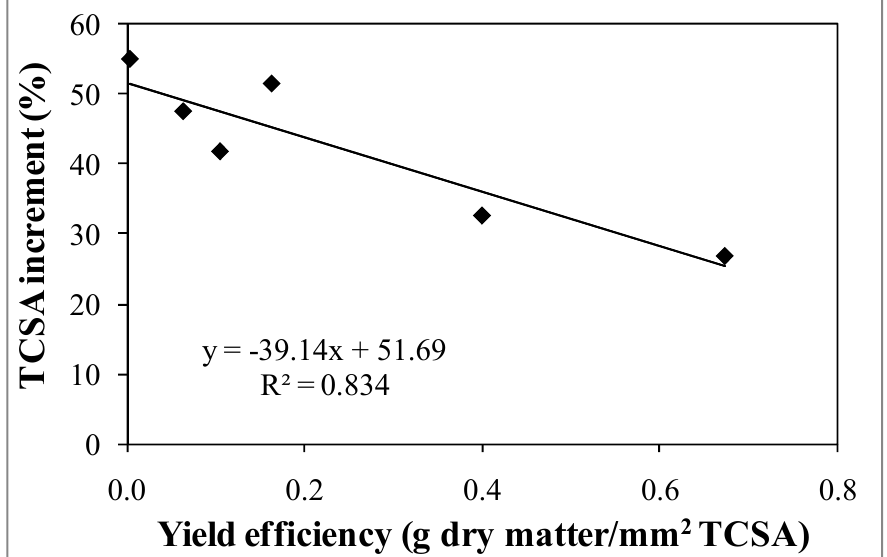
Figure 7. Relationship between the yield efficiency and the increment of the trunk cross-sectional area (TCSA) from the time of application of the NAA treatments (June) to the end of the season (December) in a young intensive olive orchard of the cultivar Moraiolo. Values are means of 4 replicates per treatment.